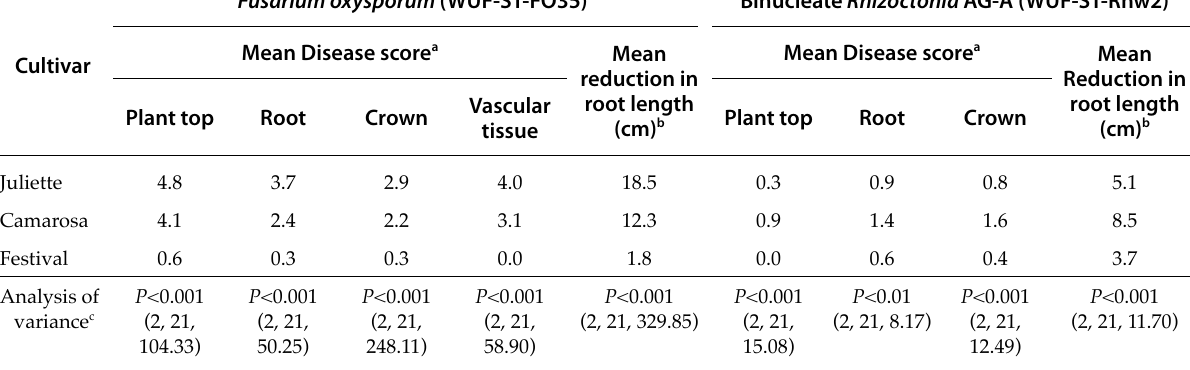
icant at P <0.05. Table 7 . Response of strawberry cv. Juliette, Camarosa and Festival to Fusarium oxysporum (WUF-ST-FO35) and binucleate Rhizoctonia AG-A (WUF-ST-Rhw2) assessed as disease scores (0‒5 scale) for plant top, root, crown and vascular tissue, re - duction in root length (cm) under controlled enrironment conditions, and analysis of variance for each parameter assessed in relation to